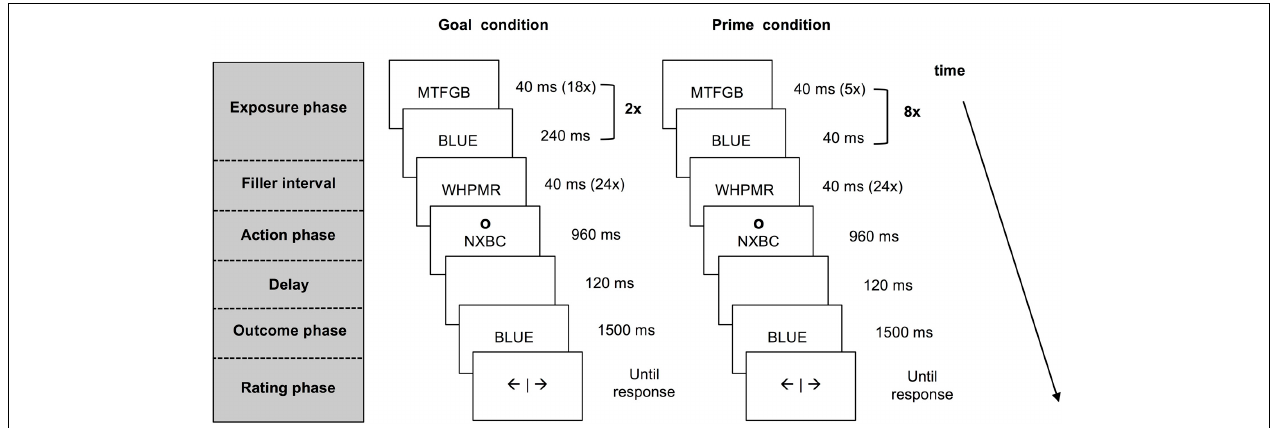
FIGURE 1 | Schematic presentation of a match trial in the agency inference task for the goal condition and the prime condition. Both goal and prime trials start with the pre-activation of a color word that is presented within a stream of letter strings. In the goal trials participants are instructed to produce this outcome. In the prime trials participants are merely exposed to